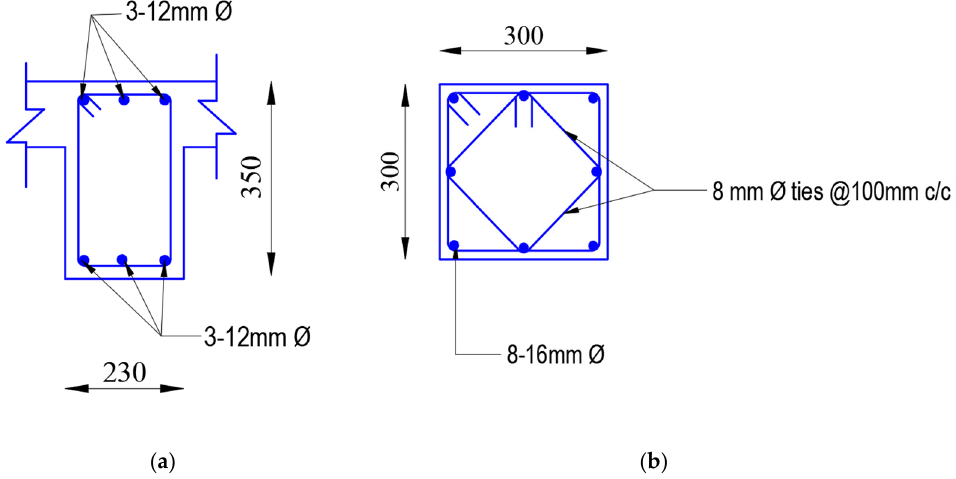
Figure 3. Geometrical and reinforcement detailing of ( a ) beam and ( b ) column sections (units in mm).